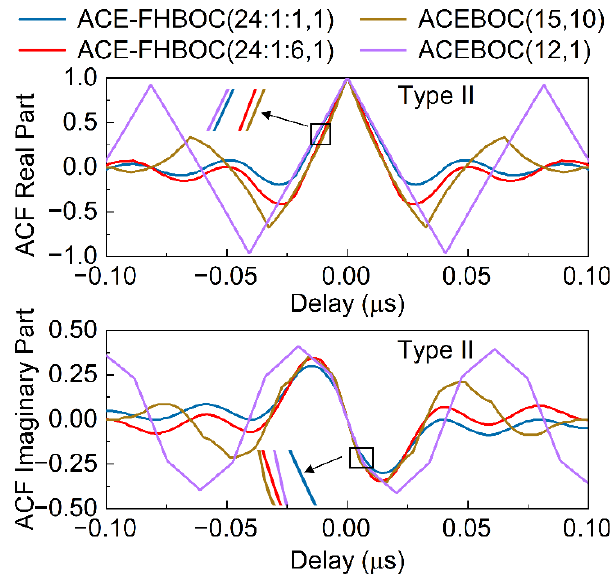
Figure 8. Normalized ACFs of the Type-II example signals.